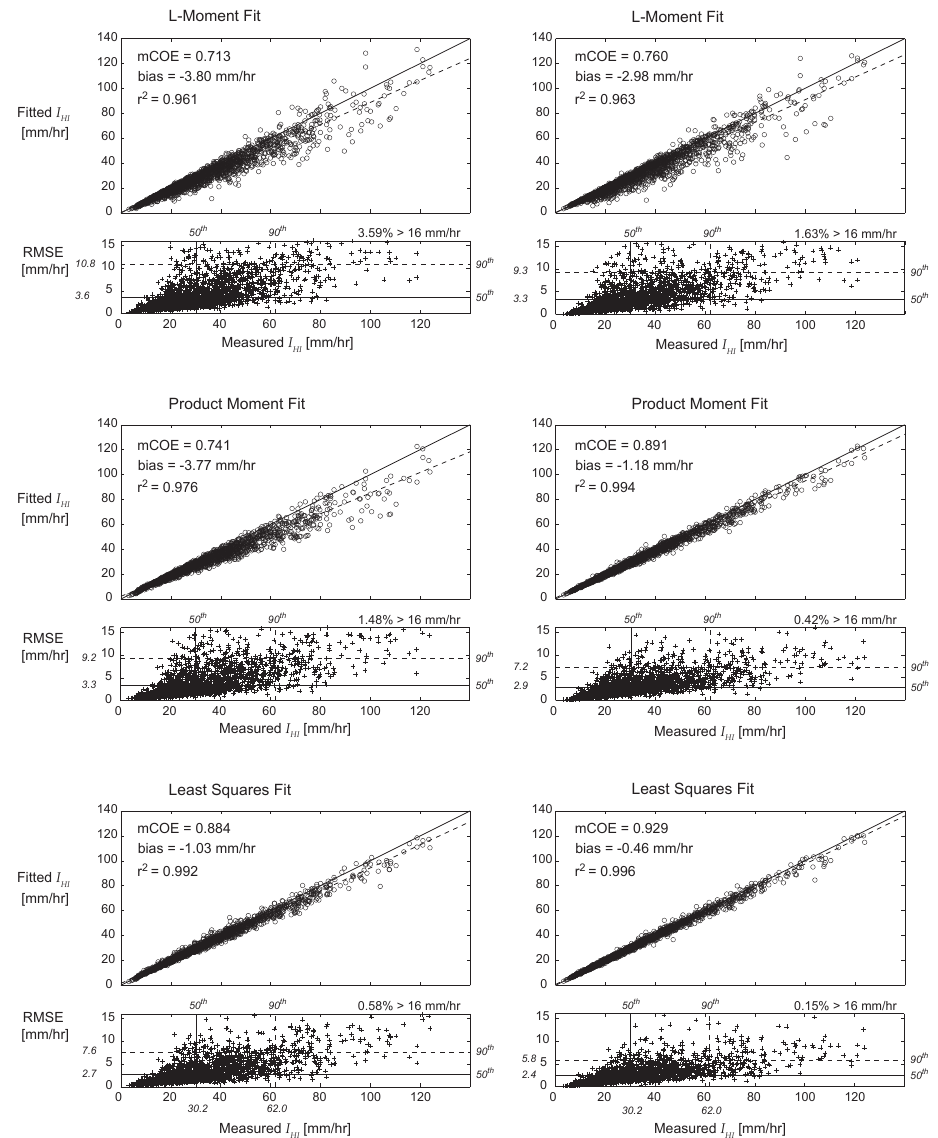
Fig. 5. Six paired scatter plots based on data from Darwin Airport are shown to illustrate first the relative skill of TDF’s having two (GPT2 – left side) or three parameters (GPT3 – right side) and second the success of three different fitting schemes: L-moments (top); Product Moments (middle); and Least Squares Estimation (lower). The plots are in pairs showing the fitted I 30 and the RMSE for each event (both plotted versus the measured I 30 ) . Values for mCOE, bias and the square of Pearson’s correlation coefficient ( r 2 ) , as well as the line-of- perfect-agreement (solid) and the linear regression line (dashed) are printed on the I 30 charts. The RMSE plots indicate the 50th (solid line) and 90th (dashed line) percentile RMSE and measured I 30 values, and also show the percentage of RMSE values greater than 16mmh − 1 and are hence outside the vertical scale of the